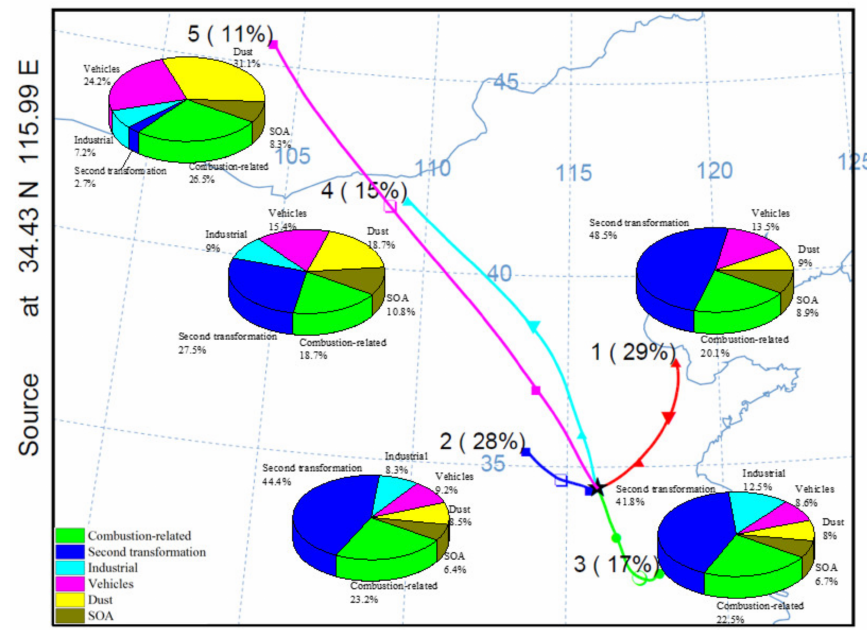
Figure 10. The clustering results and sources proportion of the different passes. Source resolution results of atmospheric PM 2.5 are classified according to air mass sources, which is helpful in determining the spatial orientation of atmospheric PM 2.5 pol- lution sources. PM 2.5 source resolution results corresponding to various trajectories are also shown in Figure 9. The contribution of secondary transformation of clusters 1, 2 and 3 which transmitted in short distance were relatively high, accounting for more than 40% of PM 2.5 and suggesting that the accumulation of local pollutants was conducive to the secondary reaction when the weather was calm and stable. The secondary transformation proportions of cluster 4 and 5 transmitted by long distance were significantly lower, es- pecially cluster 5, but the dust sources’ contributions of cluster 4 and 5 were significantly higher. Wind speed was higher during long distance transmission, so it more easily led surface dust pollution. There was little difference in the contribution of industrial sources of every cluster. The contribution of cluster 1 and cluster 3 was slightly higher, accounting for 12.1% and 12.5% respectively. Cluster 1 passed through Shandong Province, while cluster 3 was mainly influenced by cities of Anhui Province, which had more industrial enterprises. As for cluster 4 and cluster 5, mobile sources and SOA contributed more, which may be related to the route crossing Hebei. However, the contribution of combustion sources was the highest, which may be related to the primary pollutants and coal burning in winter in North